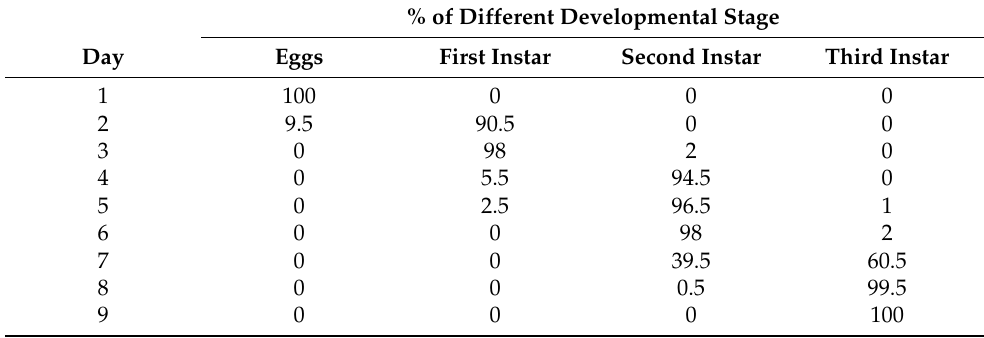
Table 1. Development of the immature stages of B . dorsalis in Tommy Atkins mango fruit following infestation in the laboratory (25 ± 1 ◦ C, 60–70% RH).